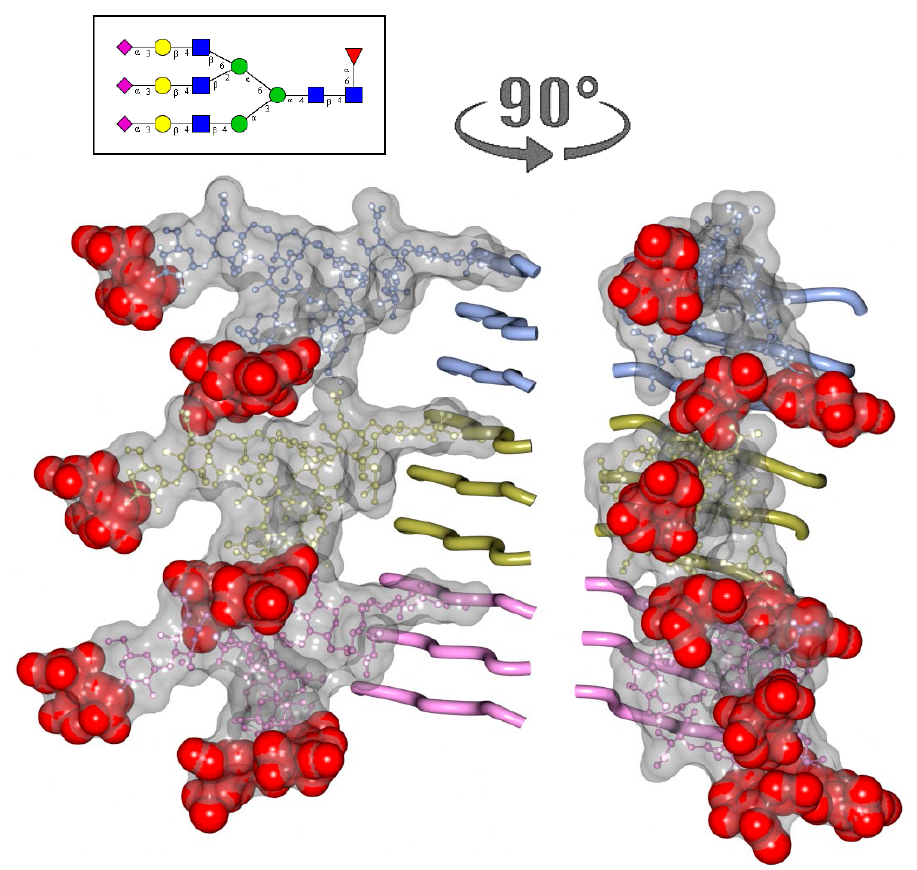
Figure 5. Modeling of N-linked glycans in PrP Sc consisting of three-rung solenoid. Two views of three-rung solenoid structures carrying tri-antennary N-glycans. Polypeptide chains are represented in the tube form, whereas N-glycans are represented in the ball-and-stick form. Each PrP molecule with corresponding N-glycan is of a different color. Sialic acid residues are colored in red. The structure of a tri-antennary N-linked glycan (shown in inset) was taken from PDB entry 3QUM, a crystal structure of human prostate specific antigen (PSA) [45]. Both calculations of electrostatic surfaces and generation of images were performed with CCP4MG software. The model based on three-rung solenoid structure is shown here for simplicity of presentation and should not be considered as preferable over the four-rung solenoid model.